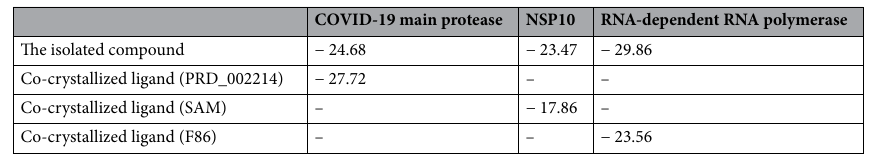
Table 3. The docking binding free energies of the isolated compound and the co-crystallized ligands against SARS-CoV-2 target proteins.